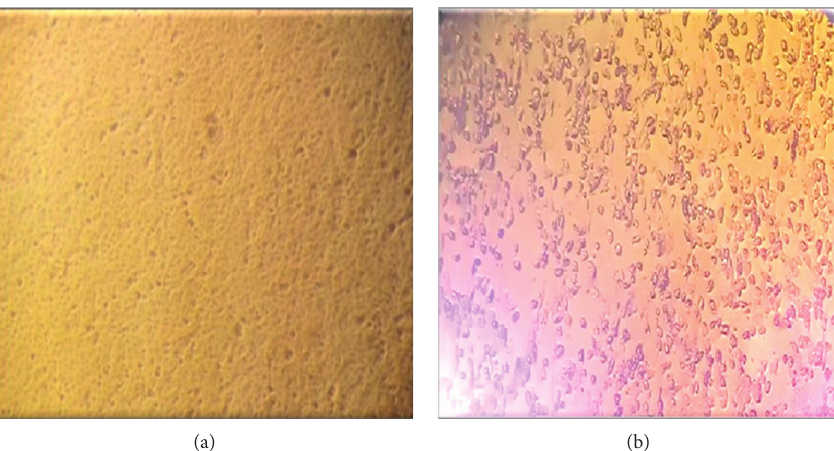
Figure 4: LSD growth on Vero cell culture. (a) Uninoculated Vero monolayer cell after 24hours. (b) Infected Vero cells showing typical CPE at 11 th day.